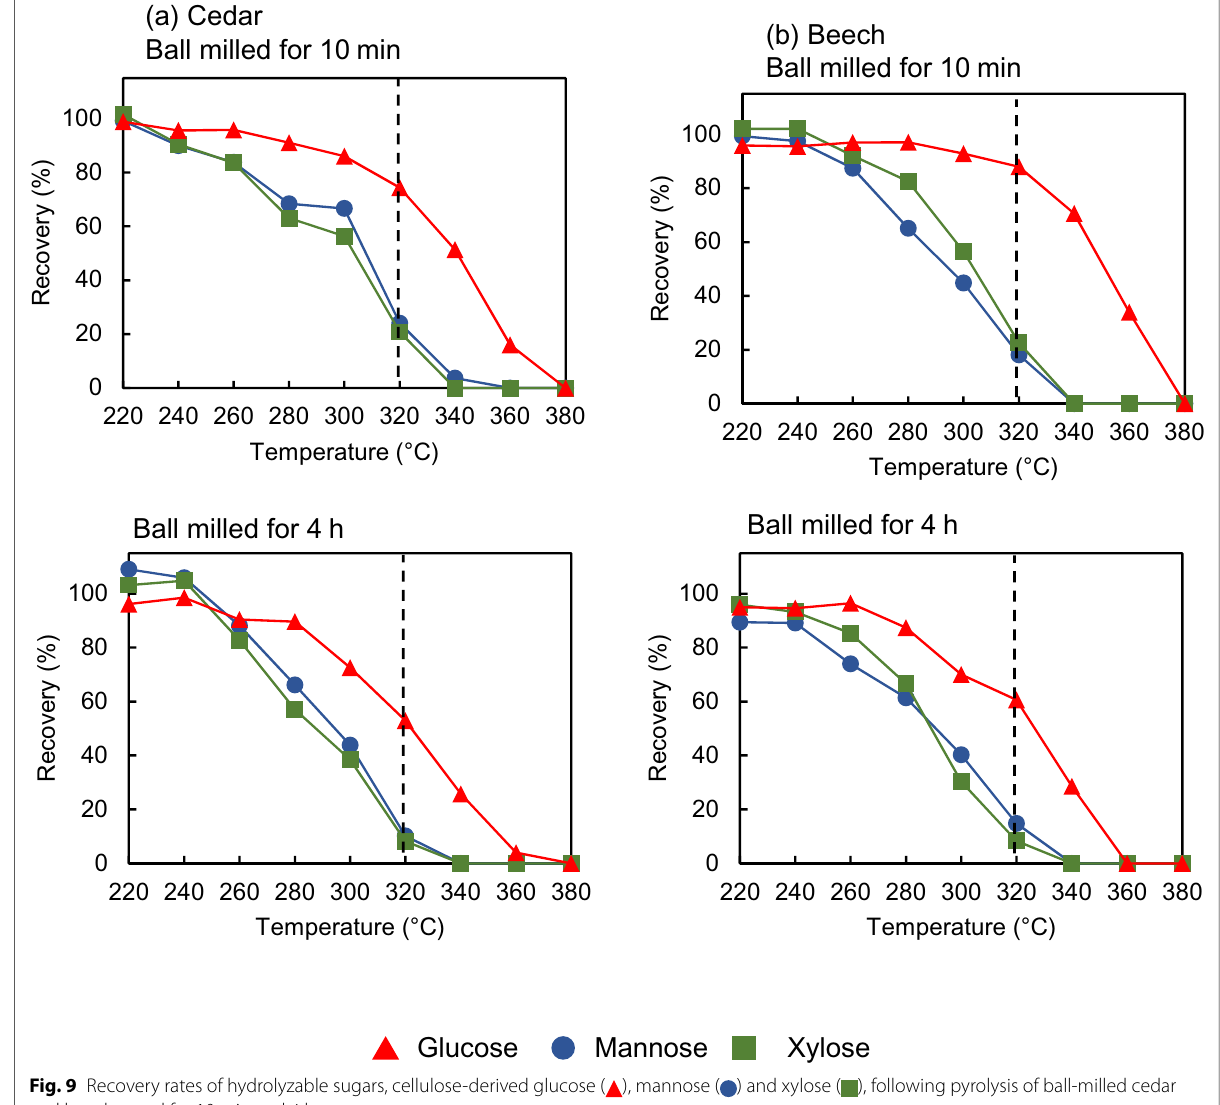
Fig. 9 Recovery rates of hydrolyzable sugars, cellulose-derived glucose ( ), mannose ( ) and xylose ( ), following pyrolysis of ball-milled cedar and beech wood for 10 min and 4